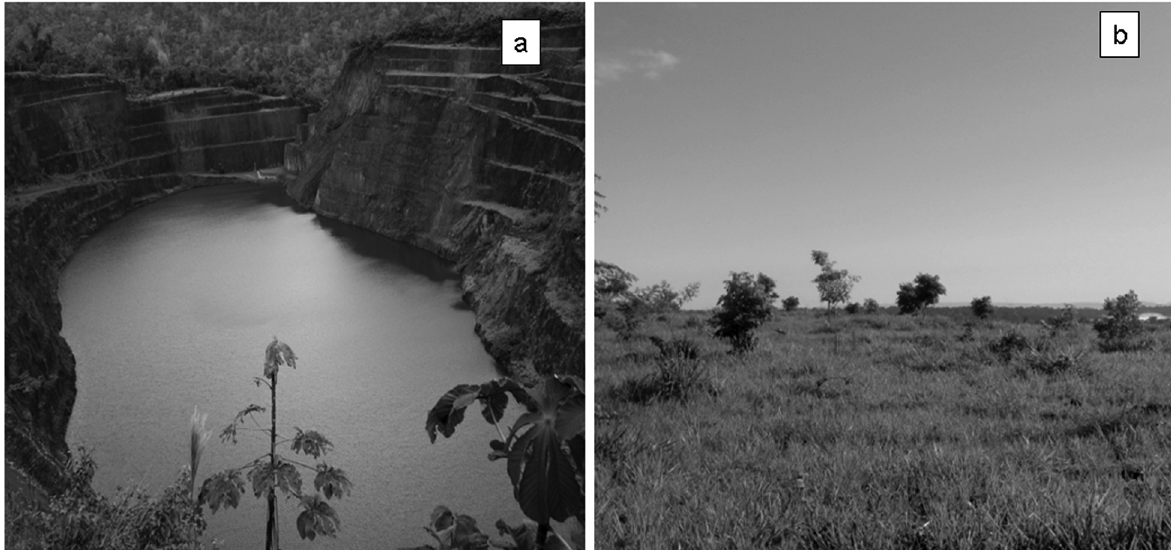
Figure 2 - Open trenches for mineral extraction which resulted in the removal of thousands of tons of soil ( a ) that were used to the plantation of Urochloa decumbens (Stapf) R.D.Webster (Poaceae) ( b